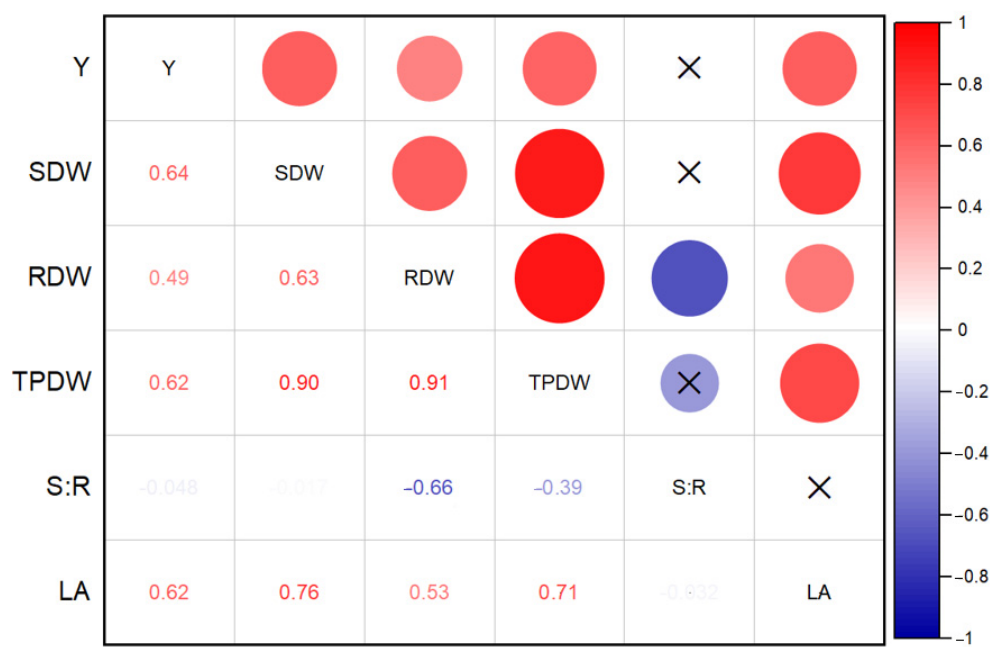
Figure 2. Correlation matrix analysis among marketable yield and studied morphological parameters. The size and colour intensity of circles are proportional to Pearson’s correlation coefficient at p < 0.01. Red circles indicate positive correlations, while blue are negative correlations. In the correlogram scale from − 1 to +1, Pearson’s correlation coefficient for variables is on the vertical and horizontal axis. × indicates values that are not statistically different at p < 0.01. Marketable yield (Y), shoot dry weight (SDW), root dry weight (RDW), total plant dry weight (TPDW), shoot to root ratio (S:R) and leaf area (LA).